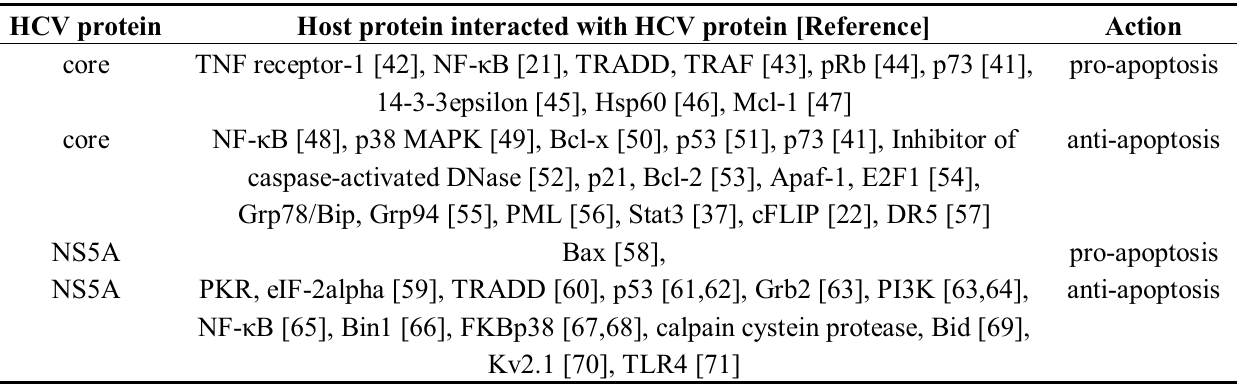
Table 1. HCV proteins core and NS5A, and